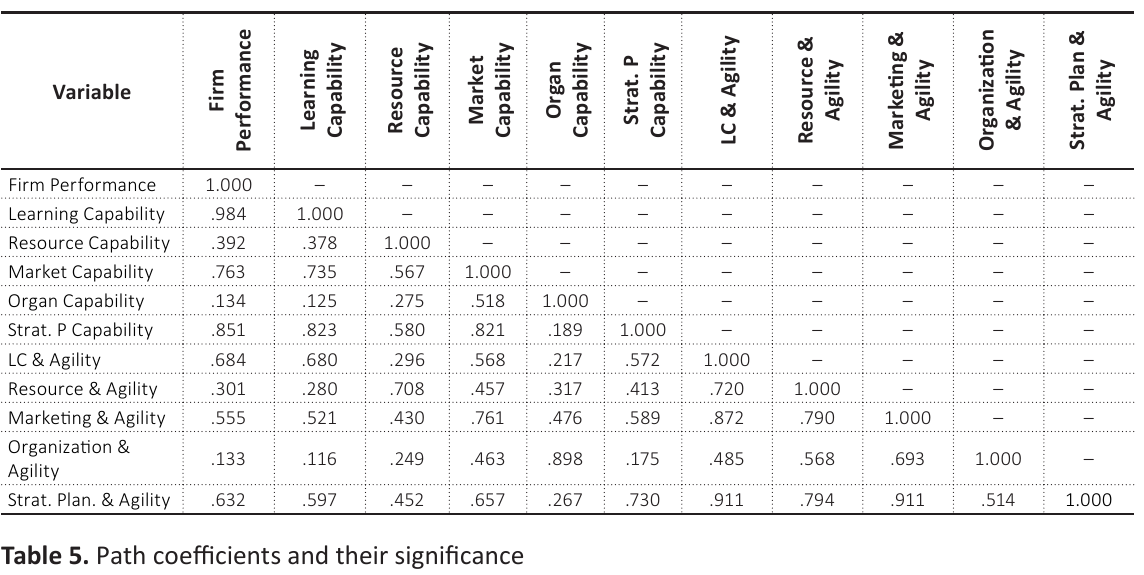
Table 4. Correlations of TICs dimensions and FP